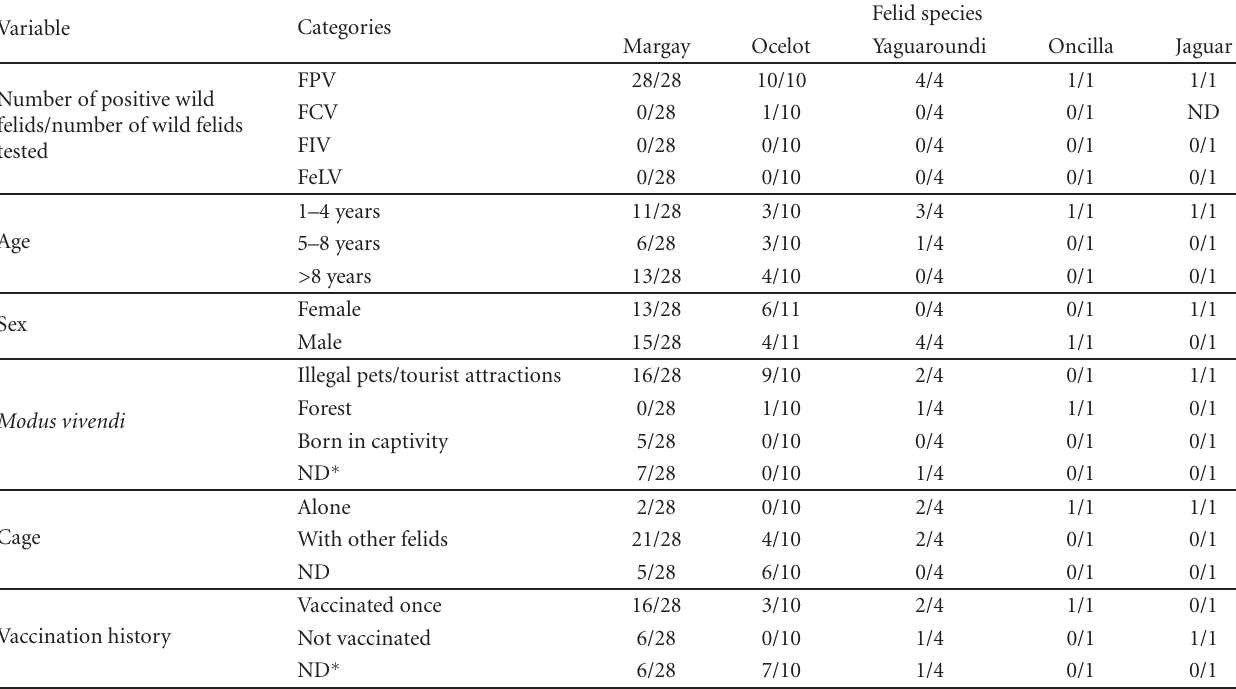
Table 1: Description of wild felids tested for antibodies against FPV, FCV, FIV, and p27 antigen of FeLV.